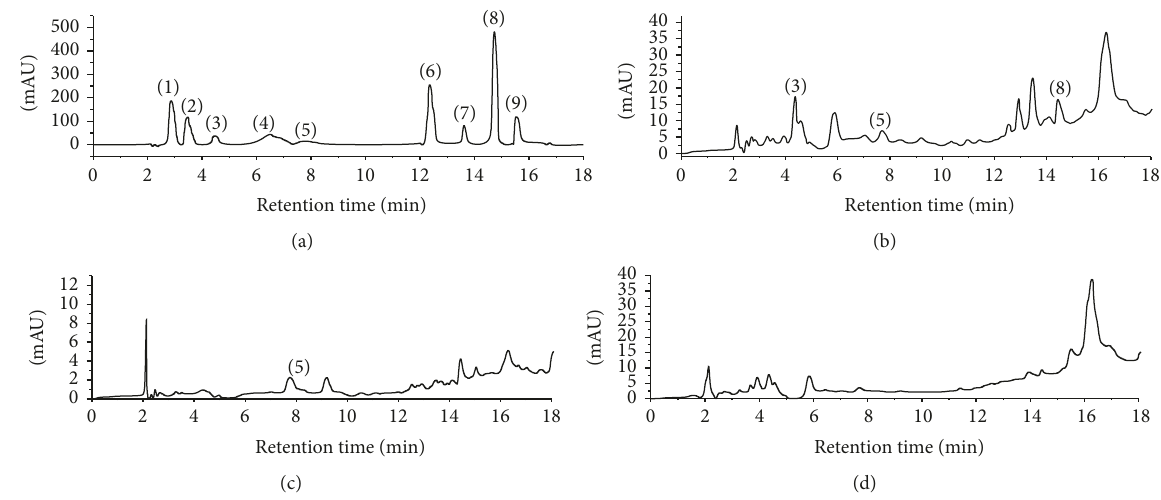
Figure 1: HPLC/DAD chromatogram of phenolic compounds in camellia oil cake. Detection was at 280 nm. (a) Standards of phenolic acids. Peak: ( 1 ) gallic acid; ( 2 ) coumaric acid; ( 3 ) catechin; ( 4 ) chlorogenic acid; ( 5 ) epicatechin; ( 6 ) rutin; ( 7 ) ferulic acid; ( 8 ) naringenin; (9) kaempferol acid. (b) Isopropanol extract (IE). Peak: ( 3 ) catechin; ( 5 ) epicatechin; ( 8 ) naringenin. (c) Normal hexane extract (NE). Peak: ( 5 ) epicatechin. (d) Diethyl ether extract (DE).